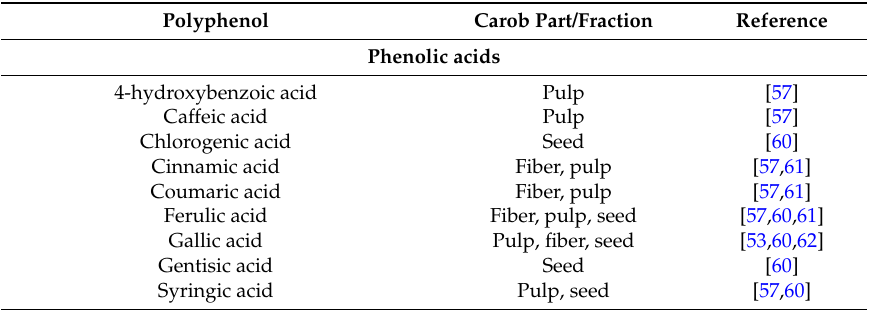
Table 1. A summary of most common phenolic compounds in different parts of carob